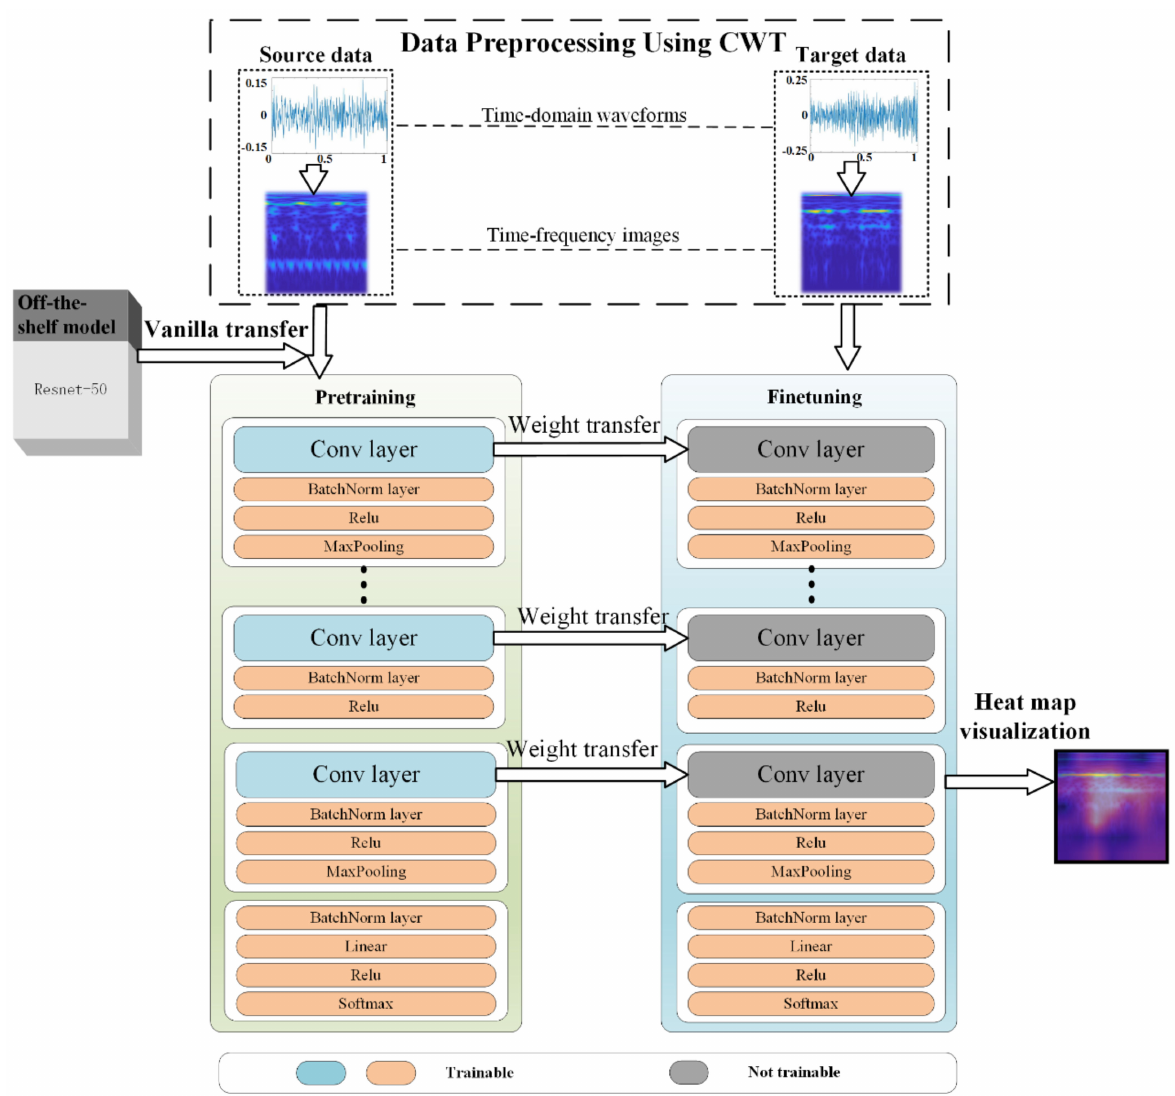
Figure 4. The proposed fault diagnosis model with intra-domain learning